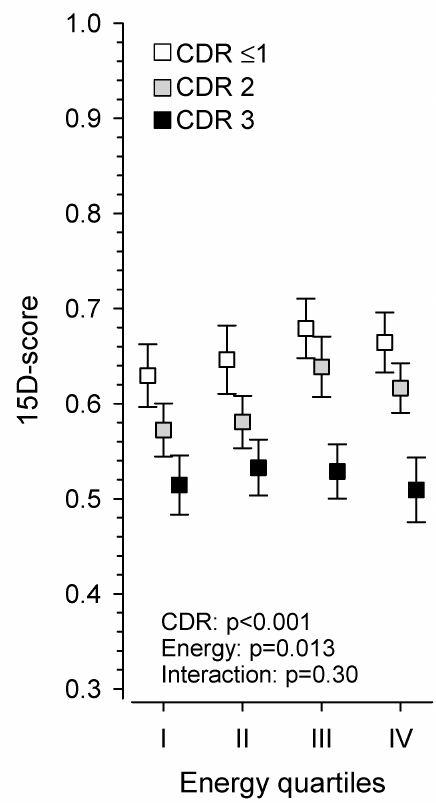
Figure 2. Relationship between the standardized energy intake per day at various stages of dementia according to the Clinical Dementia Rating (CDR) [28] with health-related quality of life (15D) [32].